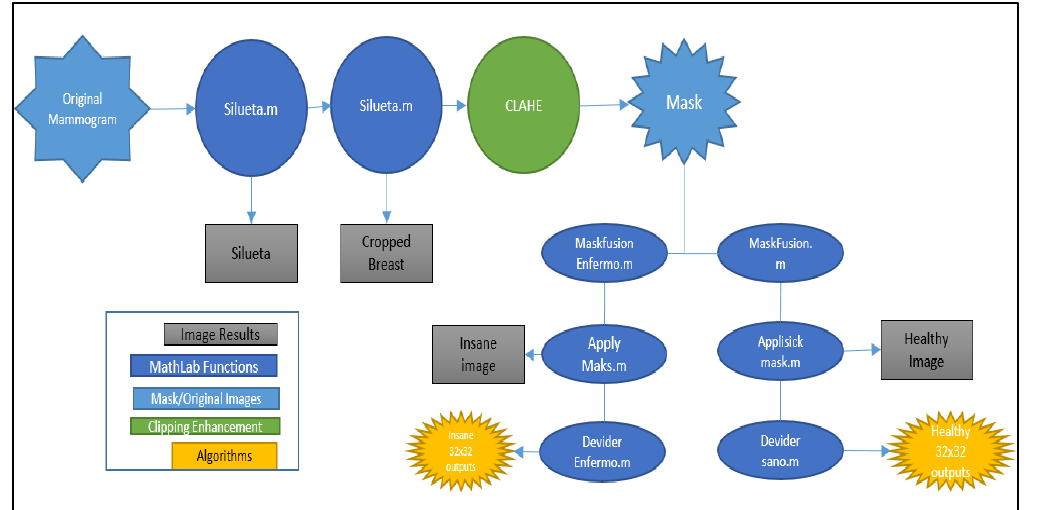
Figure 2. Diagram of the procedure for obtaining the cuts